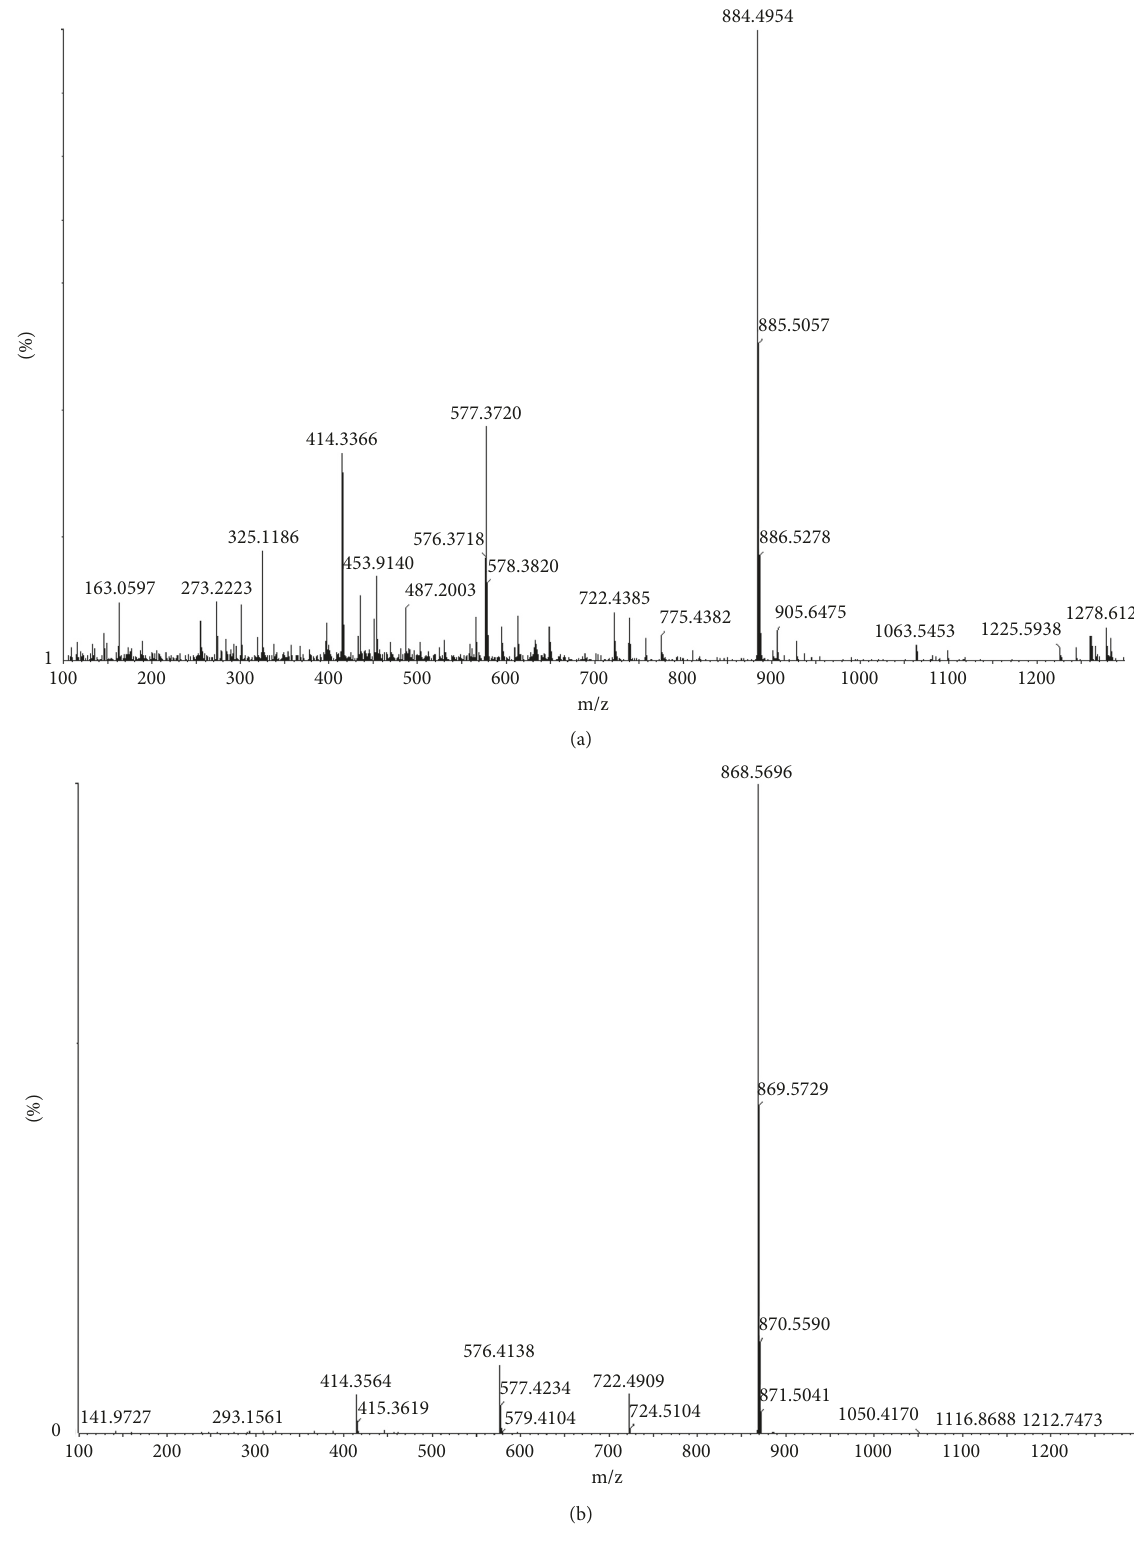
Figure 3: Mass spectra showing fragmentation pattern of solasonine (a) and solamargine